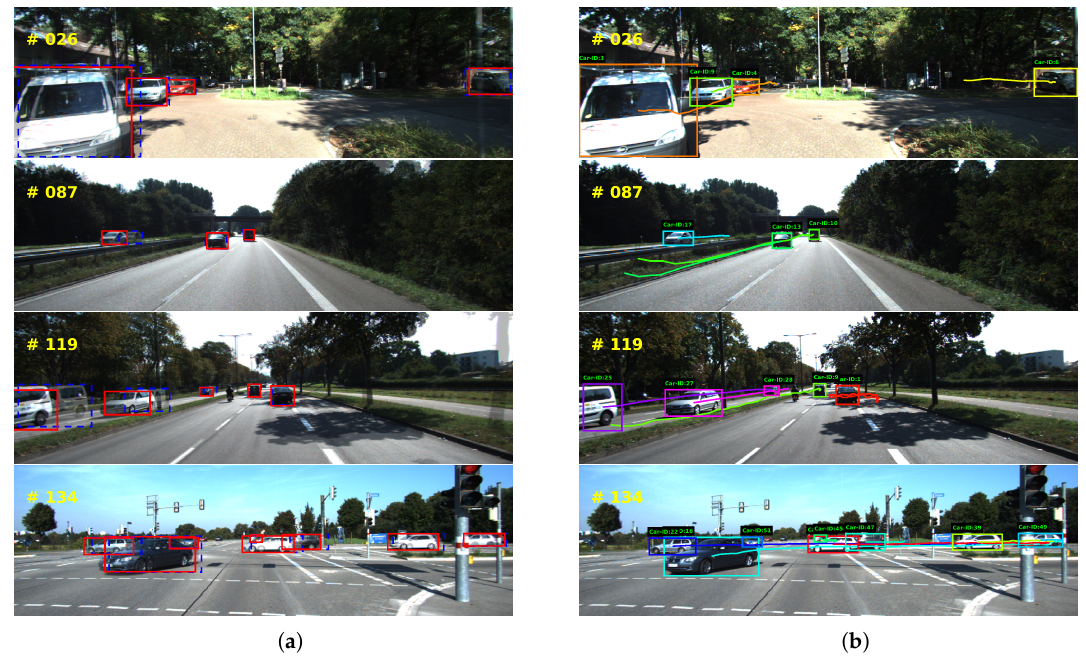
Figure 7. Experimental results on KITTI dataset. Left column ( a ) shows the tracking results with CCF, where we merged two sequential frames to make their difference apparent. The previous position are denoted with blue rectangle and the current with red. Right column ( b ) shows object trajectories. Extensive experiments were performed on dataset with various illuminations, traffic flows, and road conditions, and the results demonstrate our approach is effective for autonomous vehicle to track multi-objects.